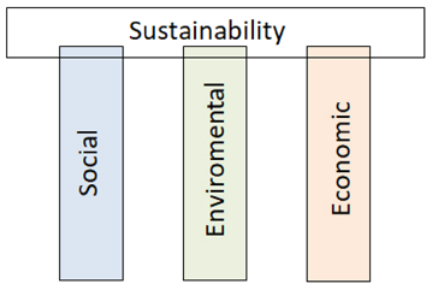
The conceptual three-pillar model of sustinability and its three contributing, core